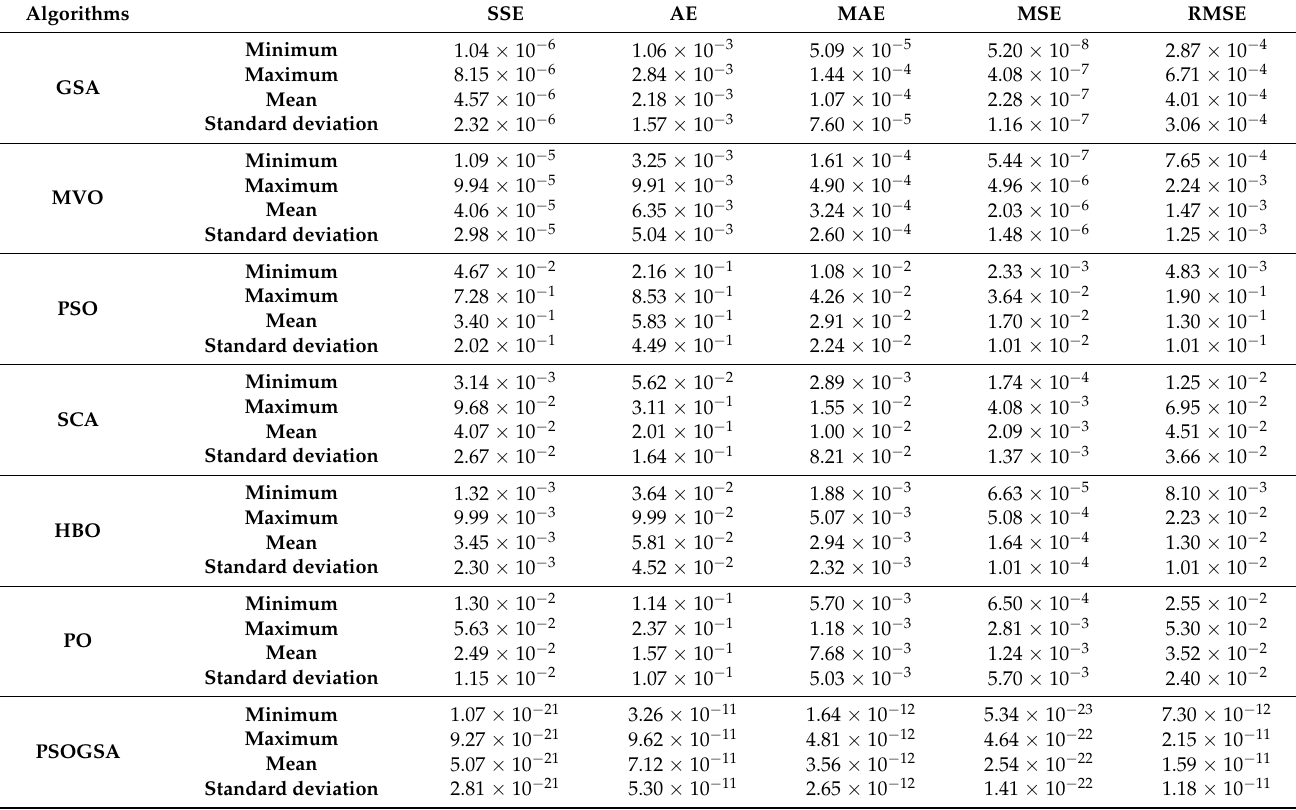
Table 13. The MSDM calculation error, mean, standard deviation for the polycrystalline PV Cell.